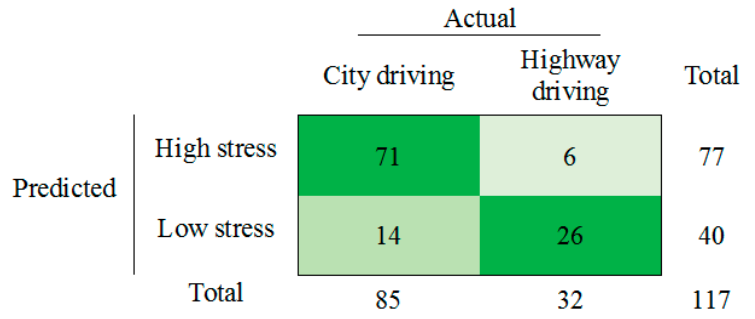
Figure 7. Confusion matrix of the model using the road type datasets.